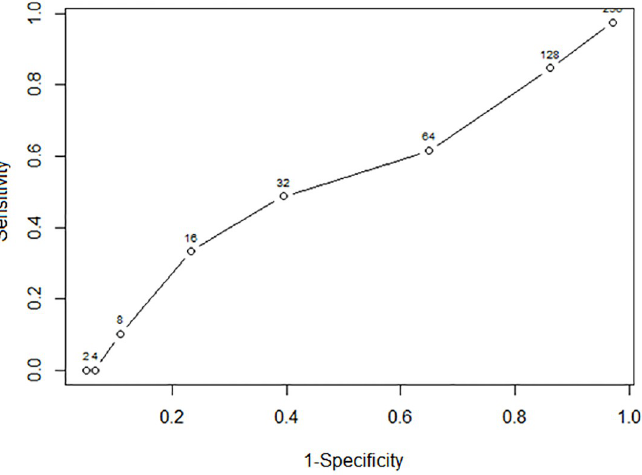
Fig 3. Receiver operating characteristic (ROC) curve for predicting infertility in relation to serum anti-GnRH antibody titres (1:X,000) in cattle.